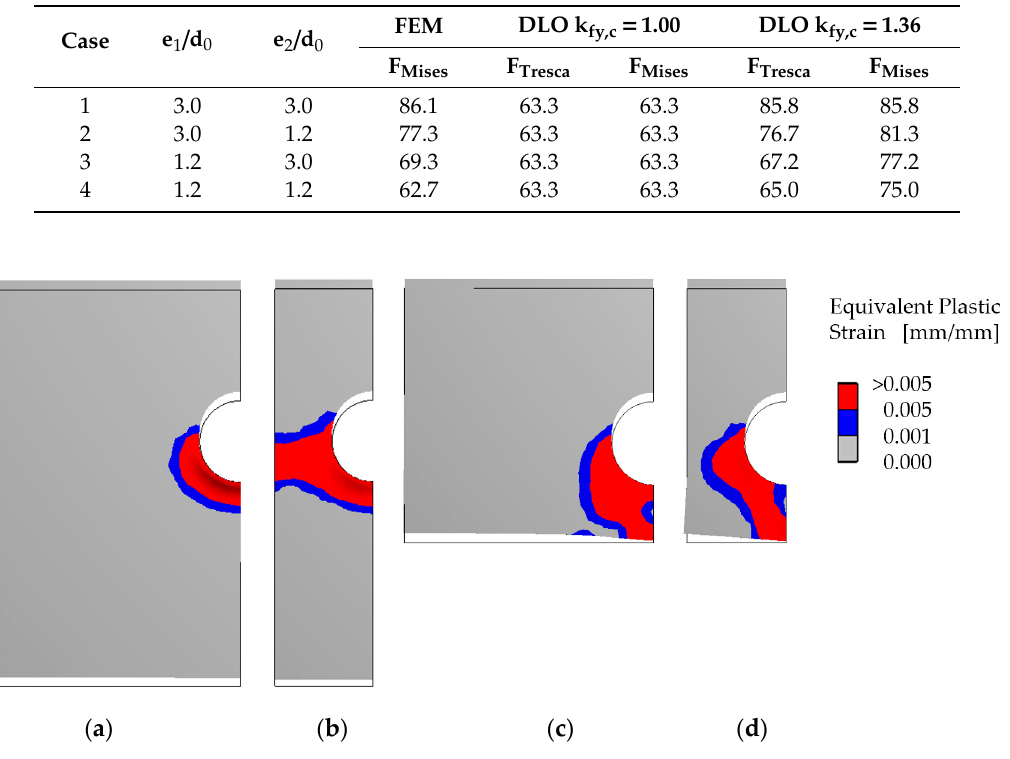
Figure 16. Failure mechanisms (equivalent plastic strain, yield surface according to the M ises criterion) from a FEA for a displacement of 0.5 mm: ( a ) Case 1; ( b ) Case 2; ( c ) Case 3; ( d ) Case 4.